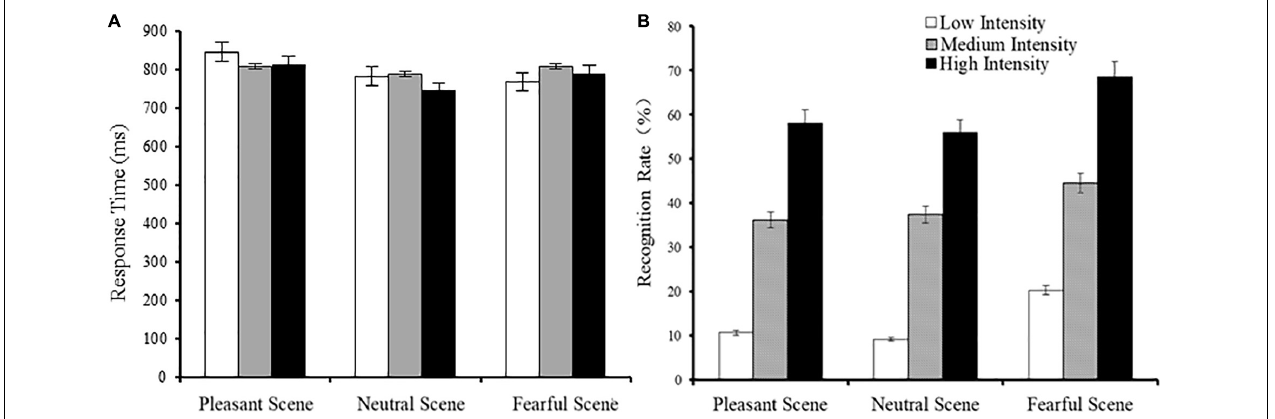
FIGURE 3 | Response time (A) and fearful expression recognition rate (B) when faces appeared in different scenes ( M ± SE ).